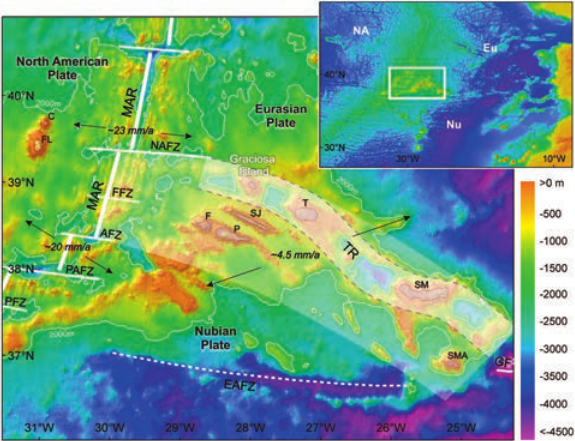
Figure 1. Main morphotectonic features of Azores region. White lines define approximately the morphological expression of each structure; white shaded area represents the sheared western seg- ment of the Eu-Nu plate boundary, whereas the white shaded area limited by a dotted grey line represents its main structure, the Ter- ceira Rift (TR). Plates: Eu - Eurasia; Nu - Nubia; NA - North Amer- ica; Tectonic structures: MAR - Mid-Atlantic Ridge; EAFZ - East Azores Fracture Zone; NAFZ - North Azores Fracture Zone; GF - Gloria Fault; FFZ - Faial Fracture Zone; AFZ - Açor Fracture Zone; PAFZ - Princesa Alice Fracture Zone; PFZ - Pico Fracture Zone. Is- lands: SMA - Santa Maria; SM - São Miguel; T - Terceira; SJ - São Jorge; P - Pico; F - Faial; FL - Flores; C - Corvo. Azores bathymetry adapted from Lourenço et al. [1997]; World topography and ba- thymetry from GEBCO_08 database [2010]. Datum: WGS